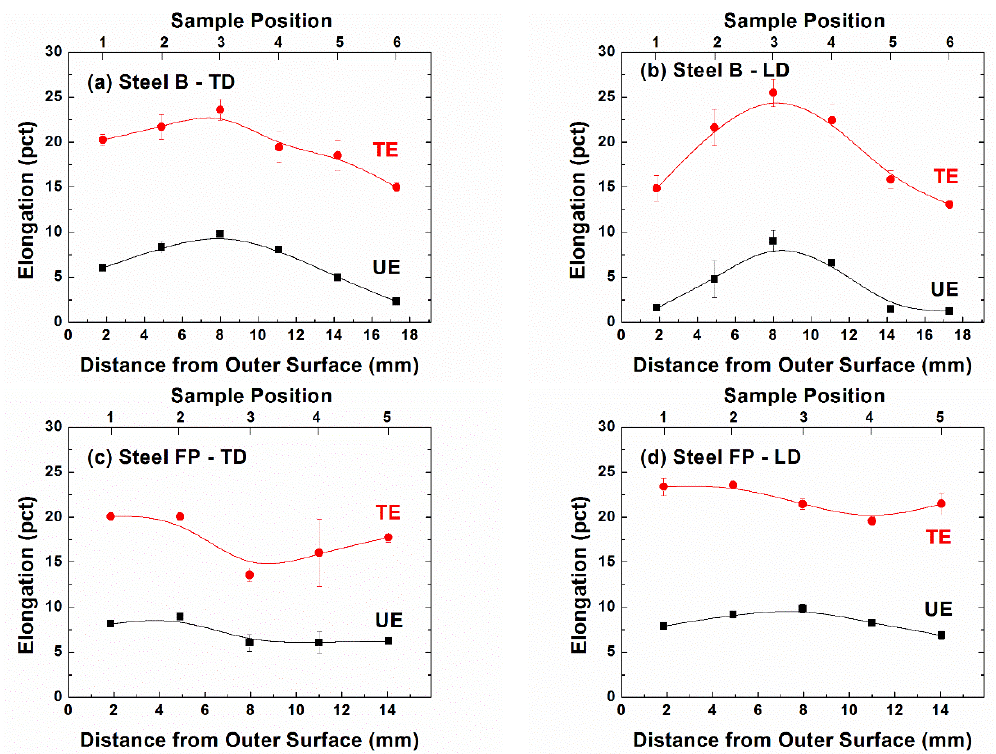
Figure 7. Uniform elongation (UE) and total elongation (TE) for steel B and steel FP obtained in the transverse direction (TD) and the longitudinal direction (LD) after flattening. ( a ) steel B-TD, ( b ) steel B-LD, ( c ) steel FP-TD and ( d ) steel FP-LD.